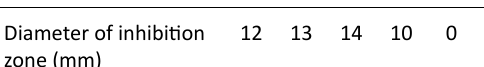
Table 2. Influence of incubation period on antibacterial activity against A. hydrophila Incubation time